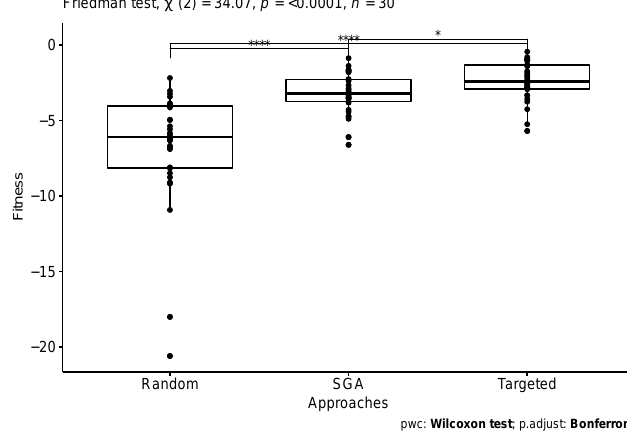
Figure 7. Box and whisker plot of Rastrigin results with Friedman test results. Note that a p value < 0.05 means that the experimental result is statistically